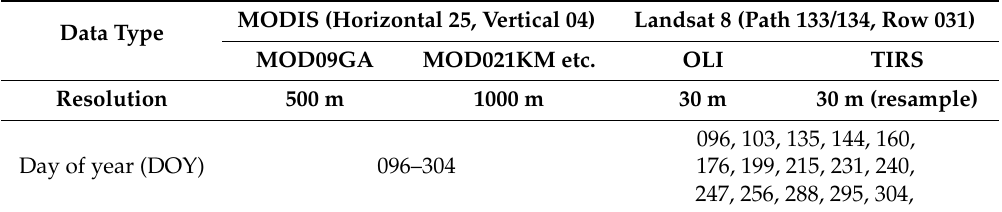
Table 2. Terra, Moderate Resolution Imaging Spectroradiometer (MODIS) and Landsat 8 data (April to October 2015) used in this study.